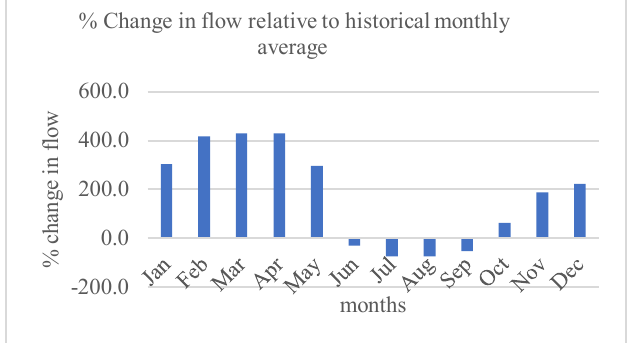
Figure 8. % change in flow relative to historical monthly